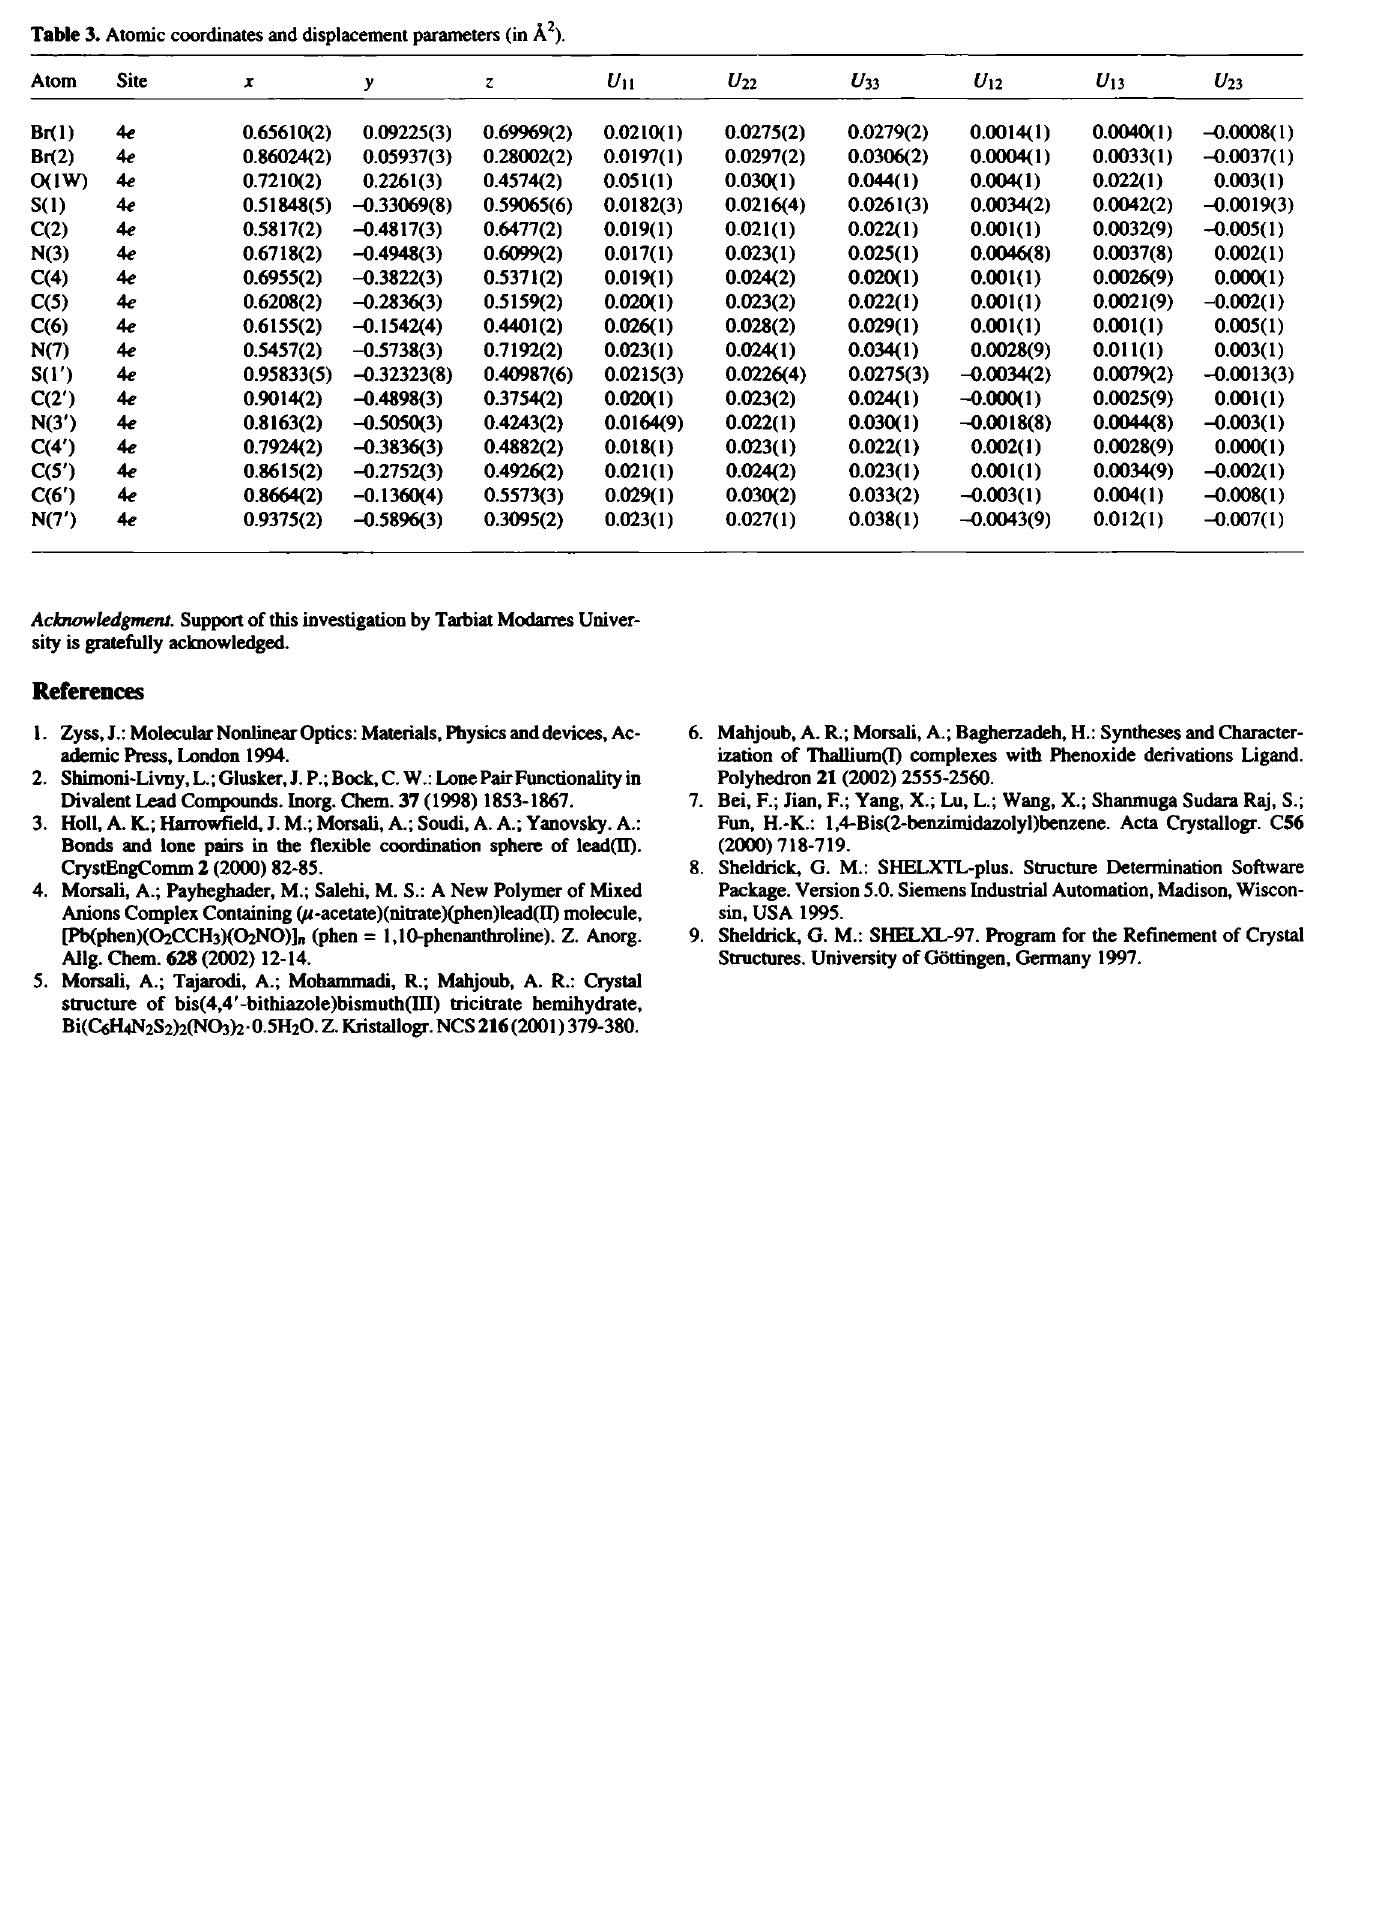
Table 3. Atomic coordinates and displacement parameters (in A 2